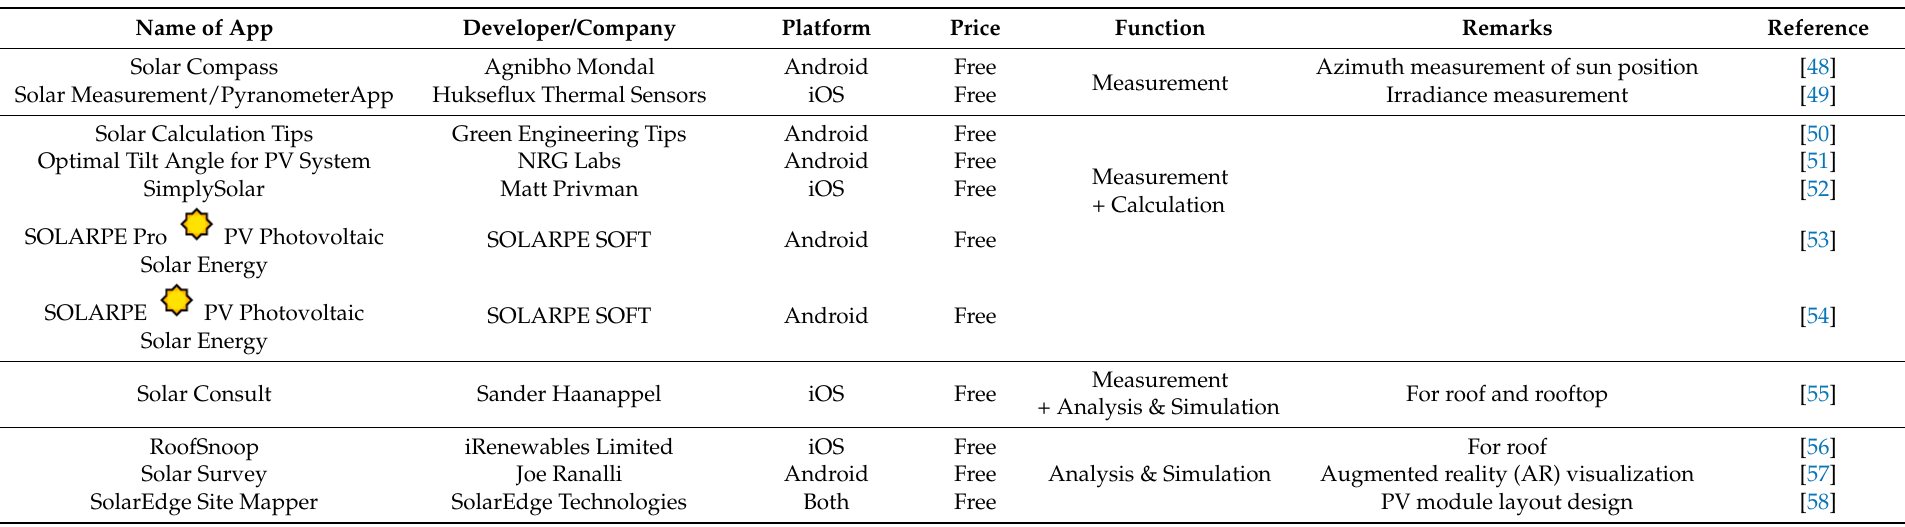
Table 5. Summary of smartphone applications for site evaluation of PV